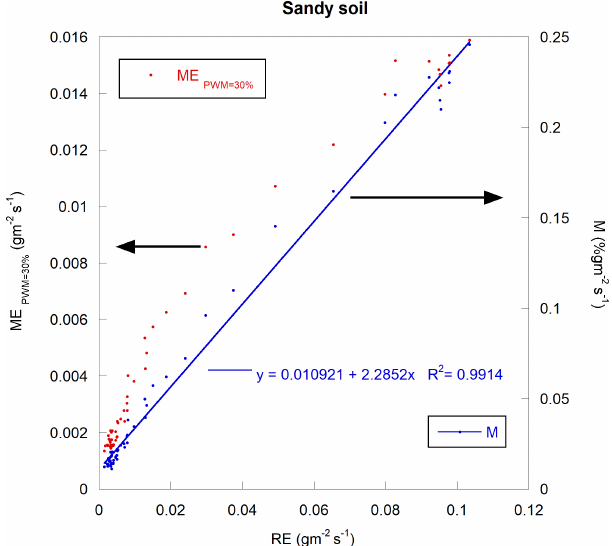
Figure 4. Measured evaporation rate versus real evaporation rate (red dots on the left-side axis) and M , averaged measure multiplied by the Z factor, along with a linear regression (blue dots on the right-side axis) for sandy soil under a 1.15ms − 1 wind speed.